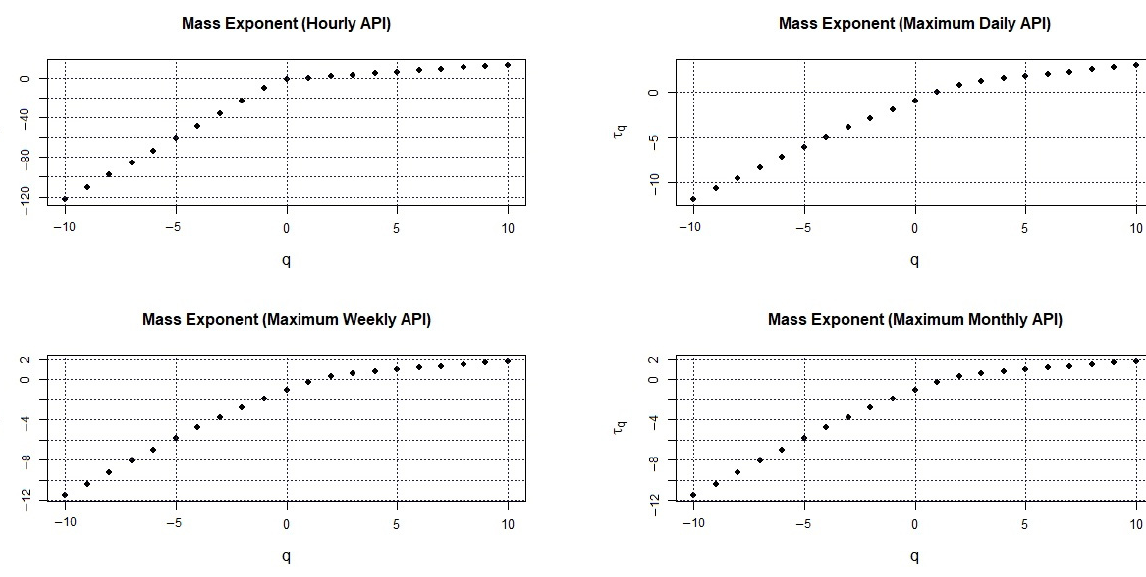
Figure 6. Plots of h(q ) versus q for hourly API series in Klang. In addition, h(q) values that are larger than 0.5 indicate that the series may have prop- erties of long memory, with persistent large and small fluctuations. In parallel, as previ- ously described by Shi [66], the series also indicates nonstationary signals with a long- range power-law correlation. By comparison, h(q) values less than 0.5 indicate that the air pollution series may have short-term memory, with intermittent or non-persistent behav- iors in both large and small fluctuations. Furthermore, h(q) values equal to 0.5 indicate complete random behaviors of the air pollution series. Figure 7a shows the values of ( ) Δ h q